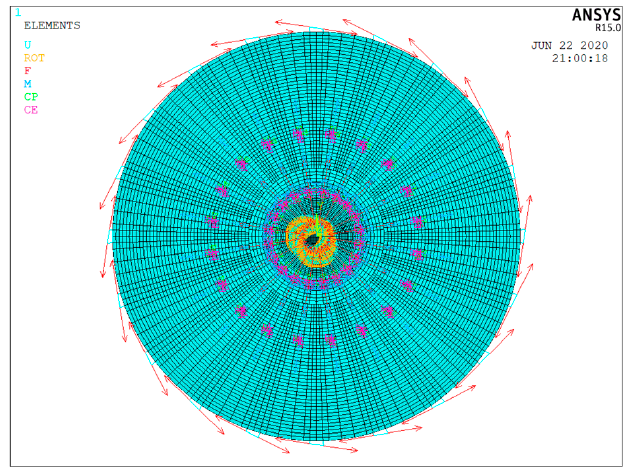
Figure 4. ANSYS model with drag springs.